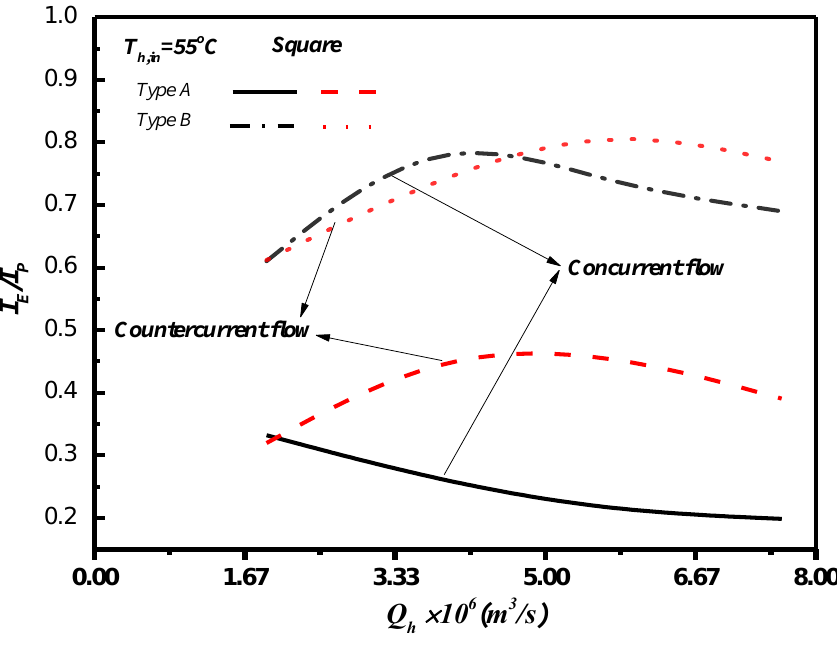
Figure 16. Effects of flow patterns on PE II /